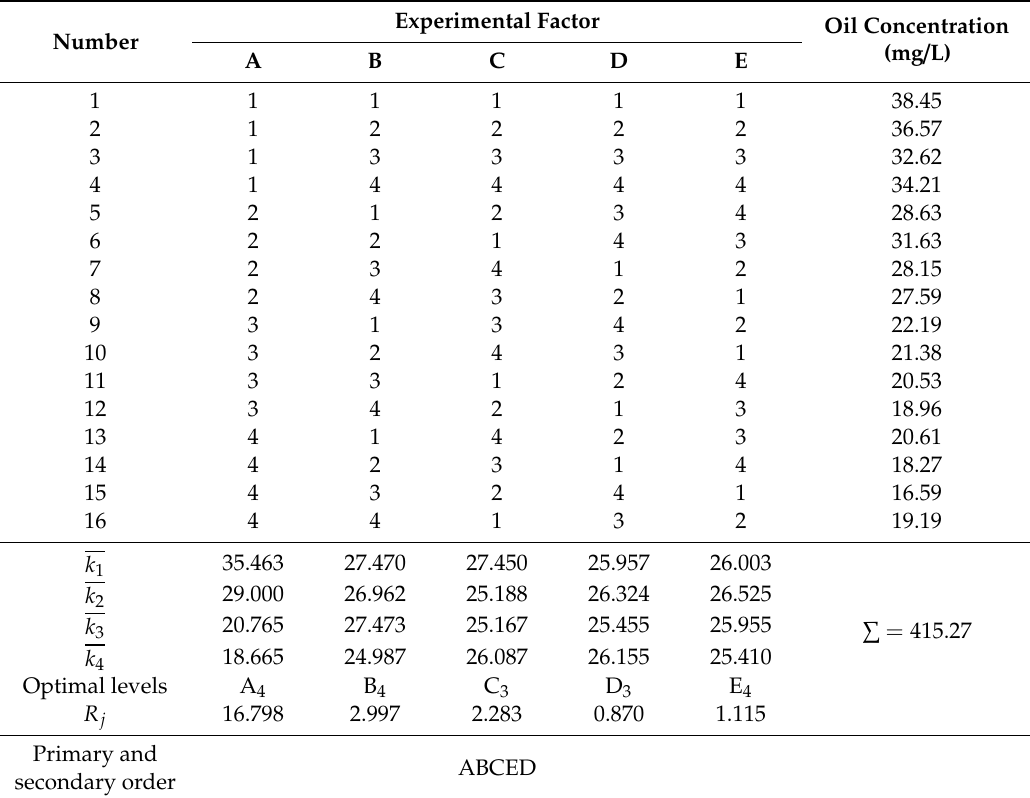
Table 8. Range analysis of the demulsification–flocculation compound system.